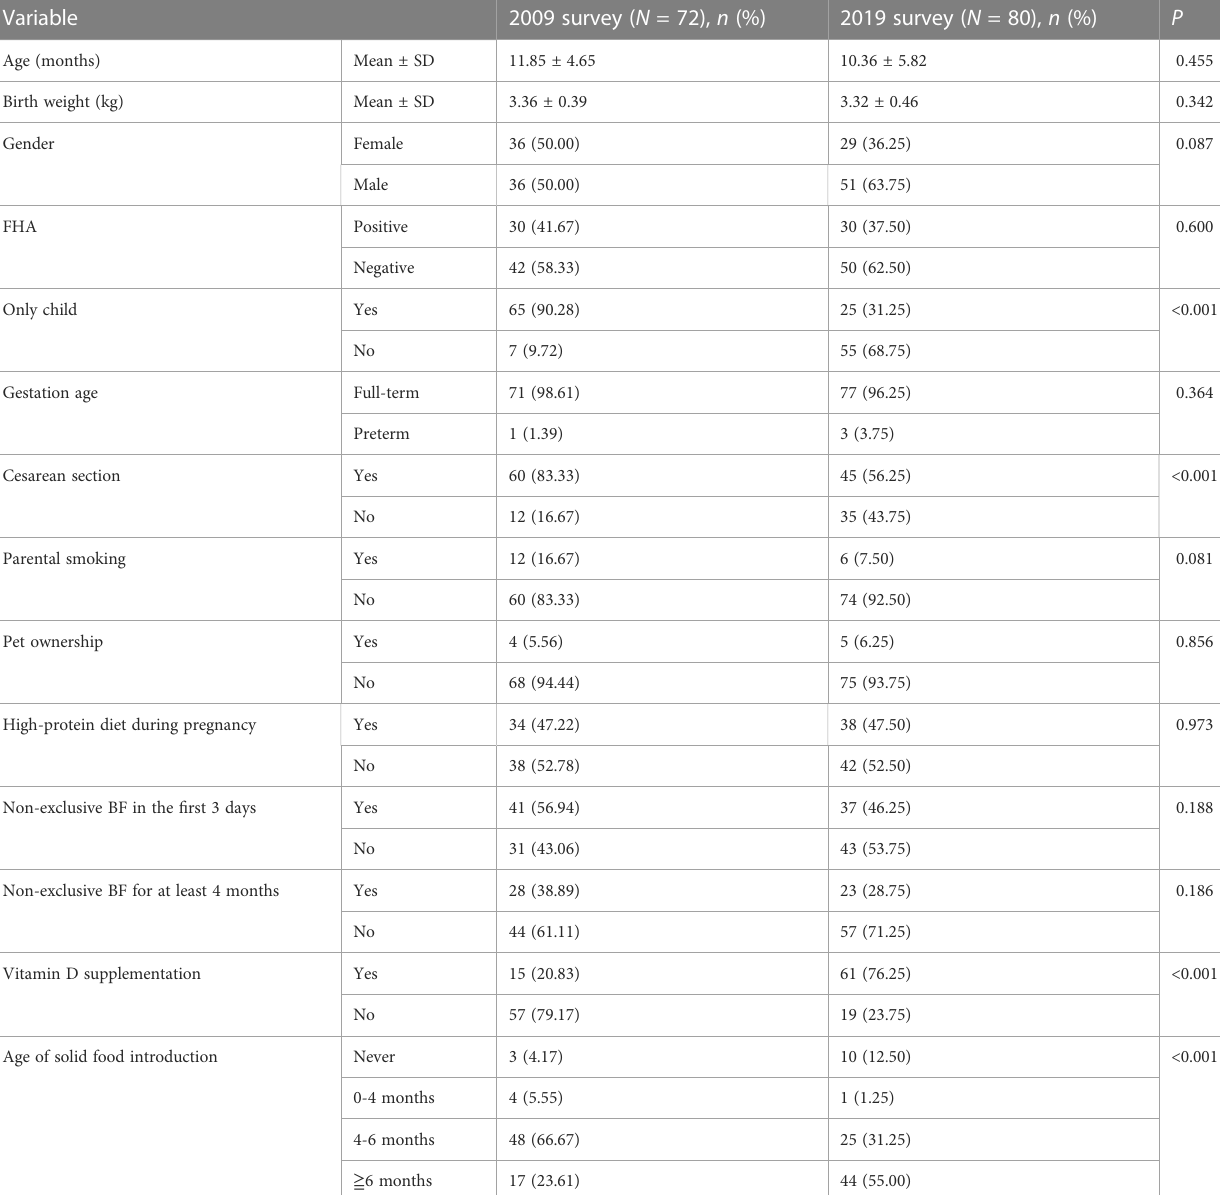
TABLE 2 Distribution of risk factors in children with food sensitization between the 2009 and 2019